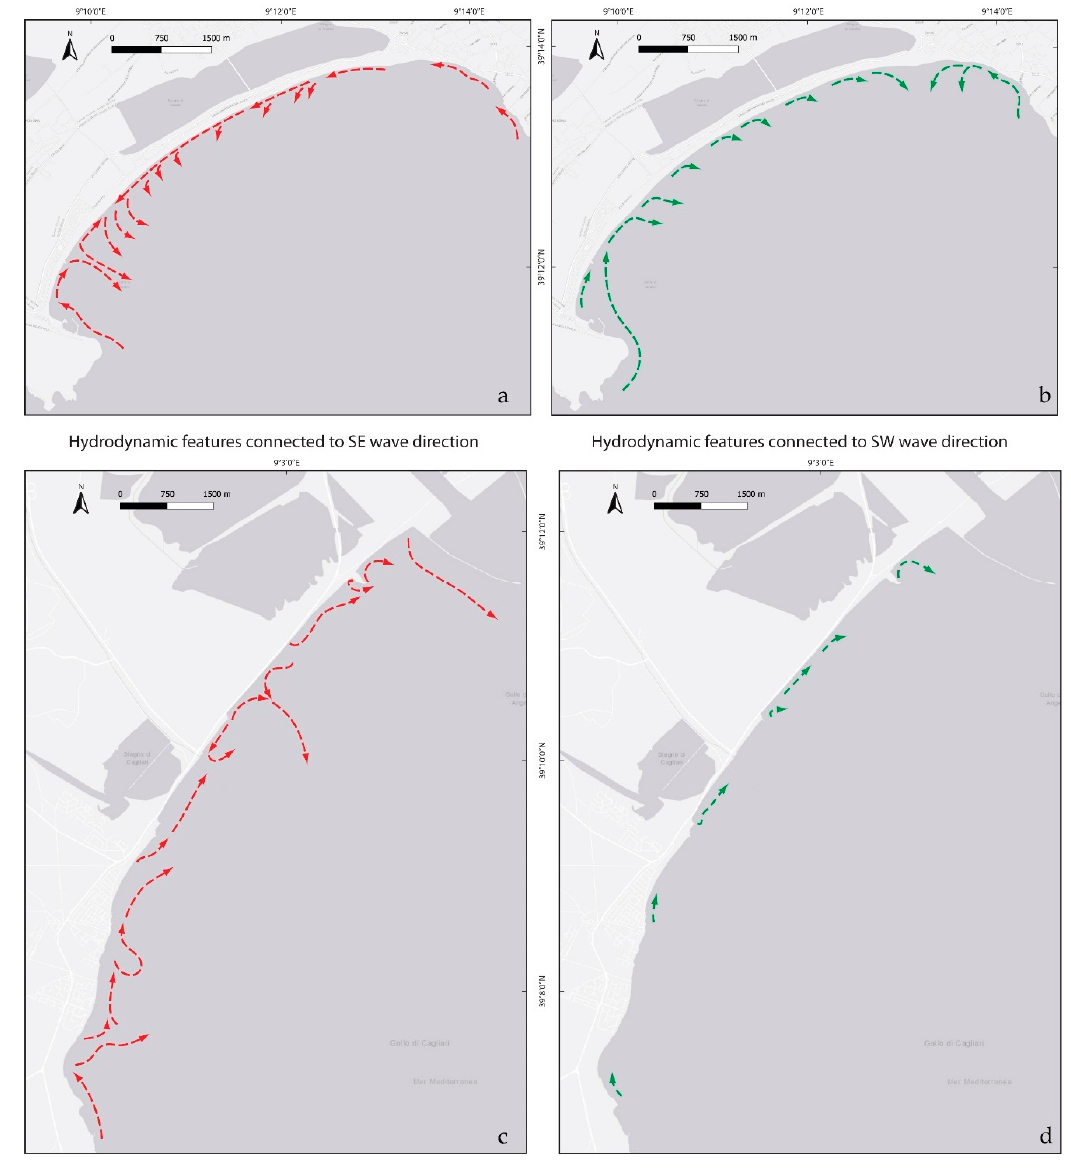
Figure 4. Schematic representation of main induced coastal currents associated with SE and SW winds at the Poetto (( a ) and ( b )) and Giorgino (( c ) and ( d )) beaches. Figures modified from [3,9].